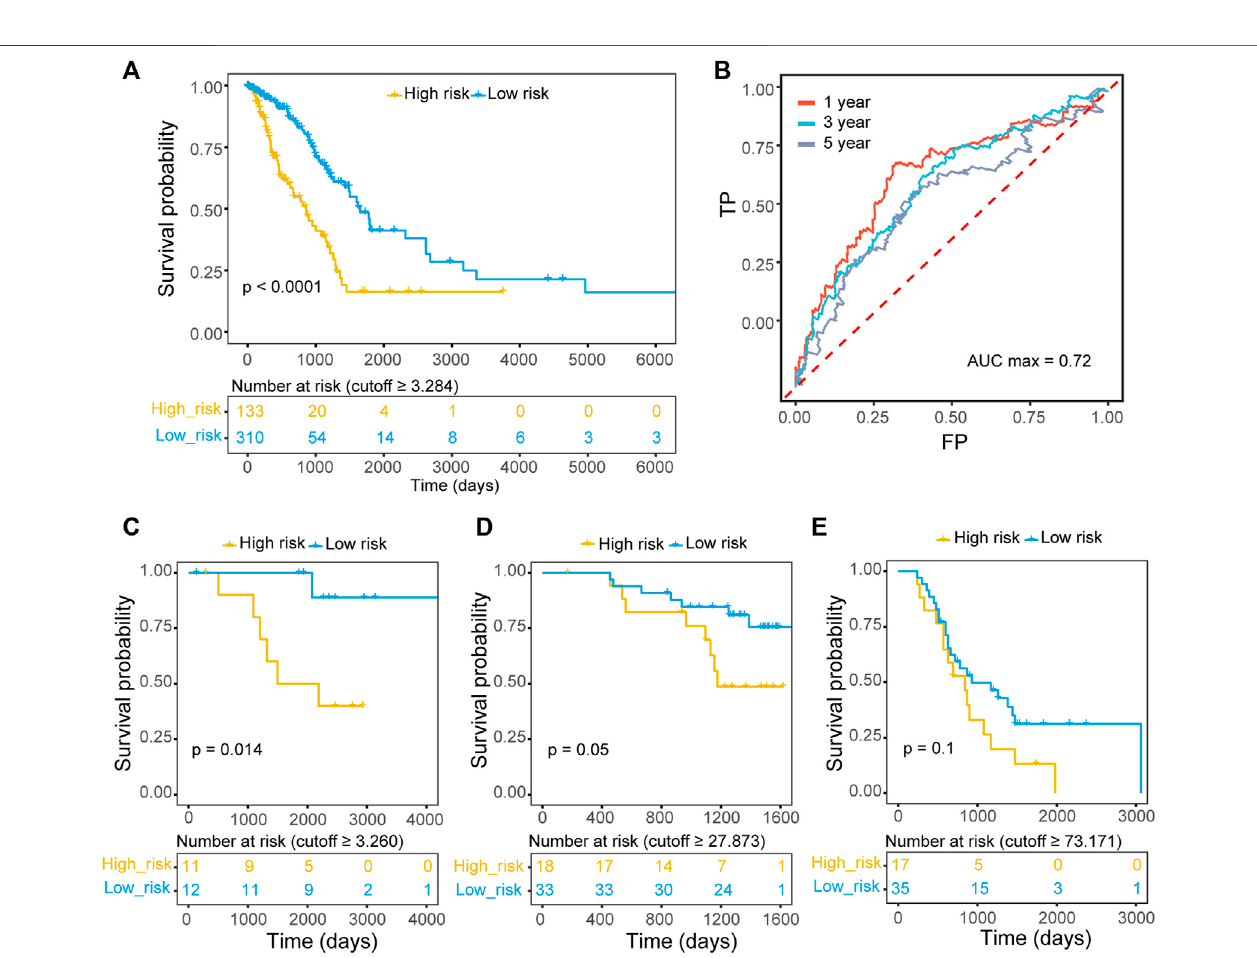
FIGURE 2 | The prognostic value of the ECM organization-related three-gene signature. (A) Kaplan – Meier OS curves with difference detection by log-rank test for patients from training data (TCGA-LUAD). Patients were divided into two groups according to the best cutoff measured by ROC curve. (B) Prognostic value of the ECM organization-related three-gene signature evaluated by time-dependent ROC curves (1-, 3-and 5-year) inTCGA-LUAD datasets. The AUCfor 1-year survival was0.72. (C – E) Kaplan – Meier OS curves with difference detection by log-rank test for patients from three validation datasets, GSE87340 (C) , GSE140343 (D) and GSE115002 (E)